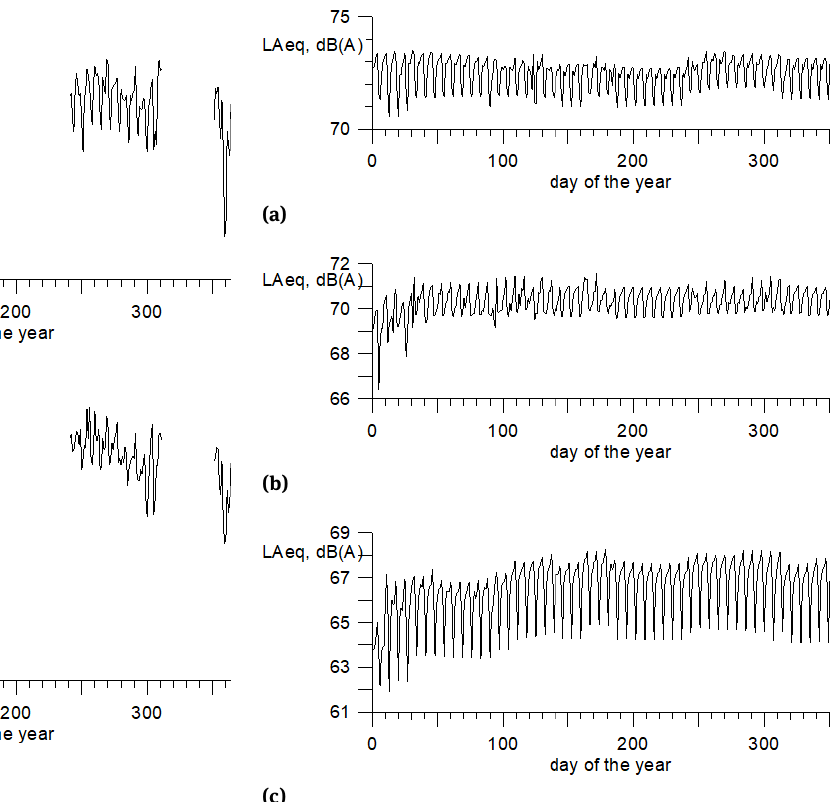
Figure 6: L Aeq calculated by the model for the location no. 3, in year 2013, for: (a) day sub-interval (6-18), (b) evening (18-22), and (c) night (22-6) in year 2013